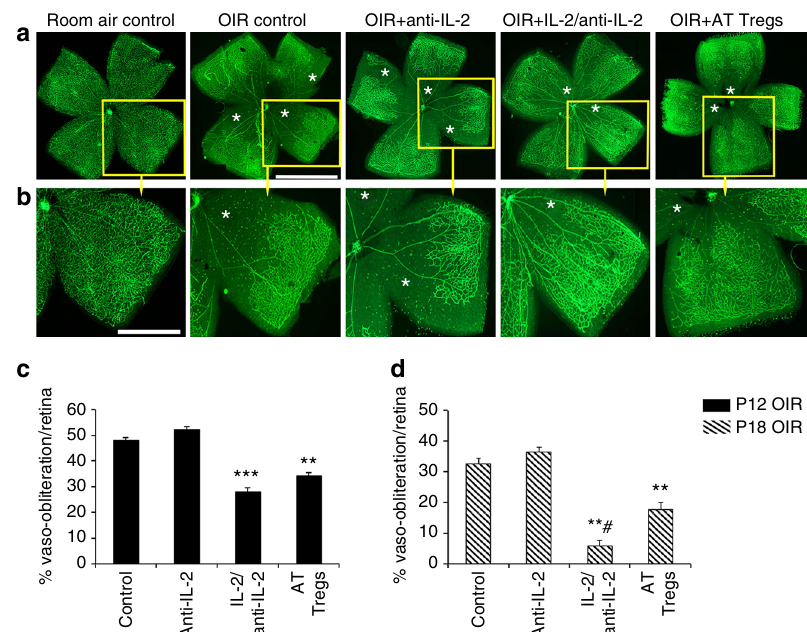
Fig. 3 Expanding Treg numbers reduced retinal vaso-obliteration in OIR. a Representative confocal images of fl at mounted retina from C57BL/6J mice at postnatal day (P) 12 in phase I OIR and labeled with isolectin ( green ) to show blood vessels. Scale bar , 0.5 mm. b One quadrant ( yellow box ) from each retina has been enlarged. Scale bar , 0.25 mm. Retinas from room air control mice show normal vascularization, while retinas from OIR controls and OIR + anti-IL-2 mAb have vaso-obliterated blood vessels ( asterisks ) in the central retina. Mice treated with an IL-2/anti-IL-2 mAb complex or adoptively transferred (AT) Tregs have reduced retinal vaso-obliteration. Quantitation in phase I OIR at P12 c and phase II OIR at P18 d ** P < 0.01 and *** P < 0.001 to OIR control groups. # P < 0.05 to OIR + AT Tregs (one-way ANOVA with Mann – Whitney U test). n = 9 mice/group with three litters examined. Values are mean ±